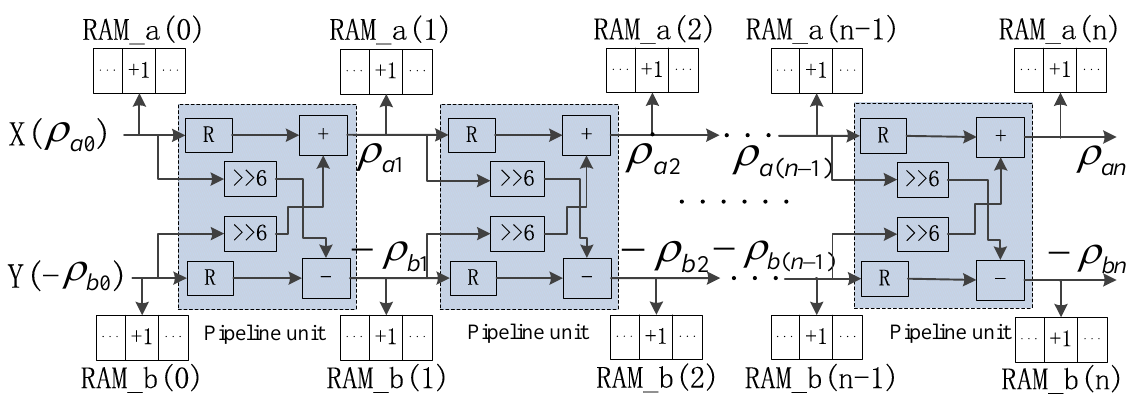
Figure 10. Multi-level pipelined PHT